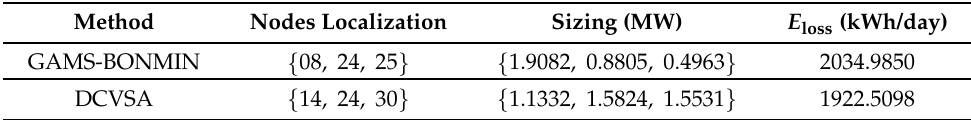
Table 8. Comparison of energy losses for the 33-node